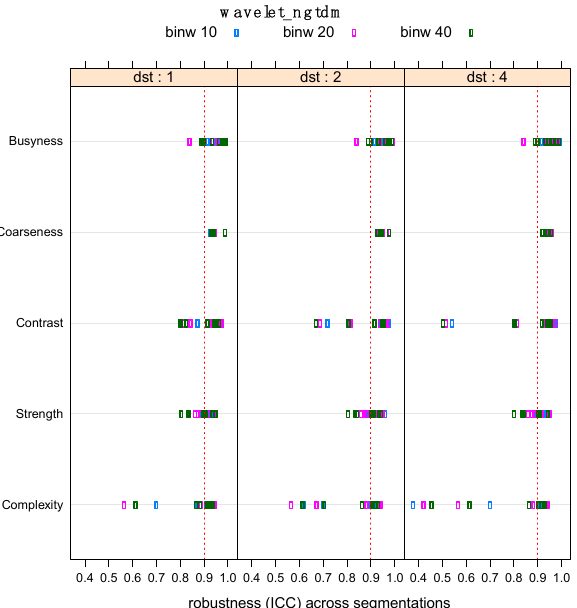
Figure 15. Sensitivity to other parameters. Per each feature, the range of variation of ICC is reported per each parameter (bin-width, pixel distance, interpolator and isotropic resolution) having fixed the other three.